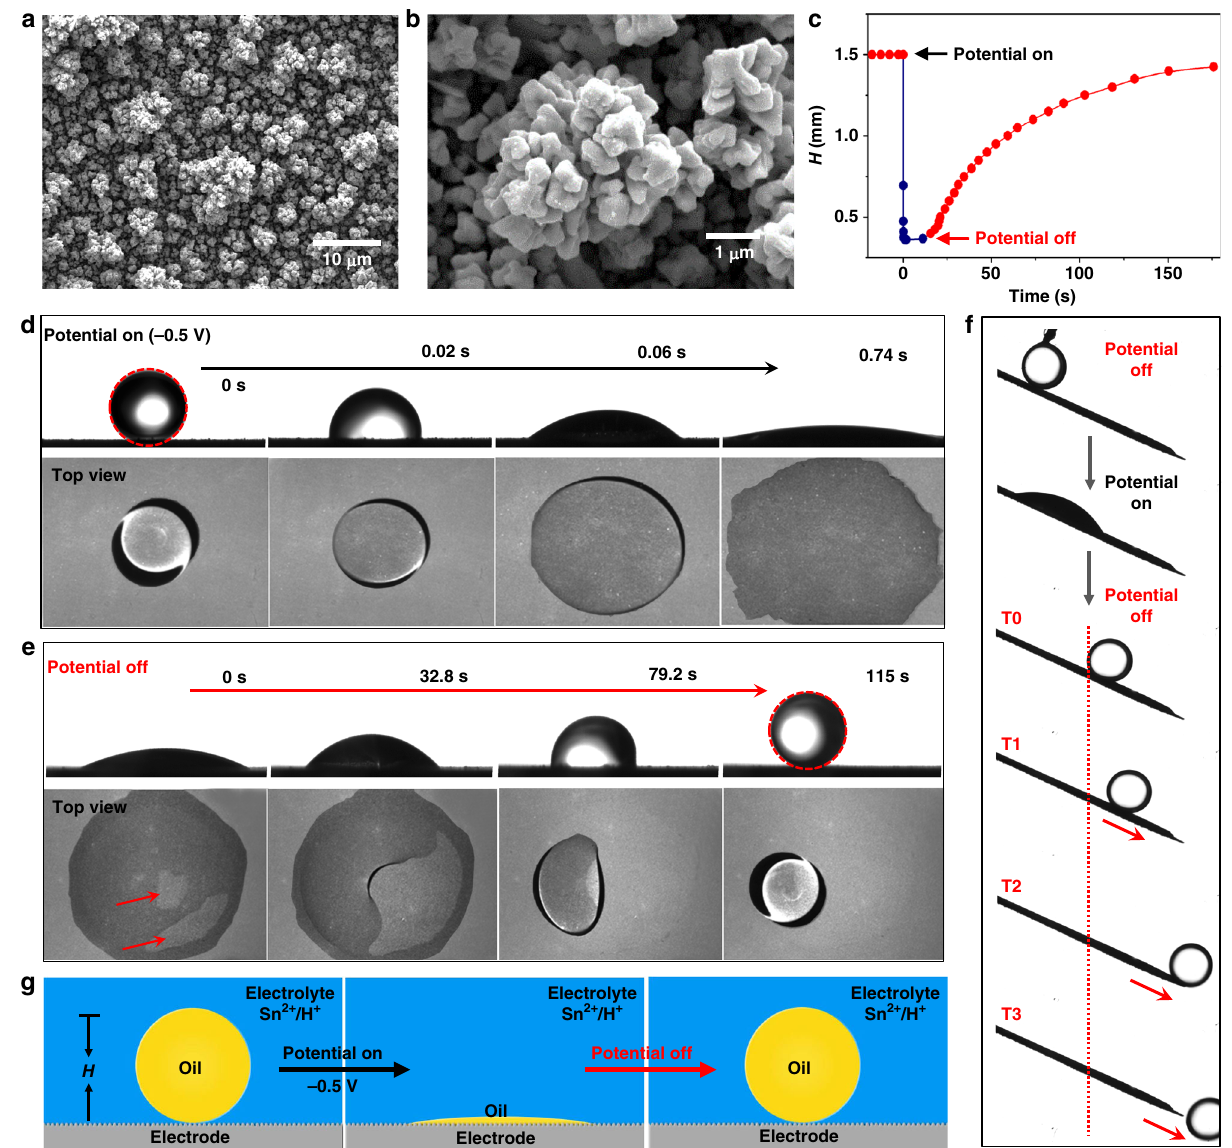
Fig. 1 In situ reversible superwetting transition between underwater superoleophilicity and superoleophobicity. a , b Scanning electron microscopic images of the copper electrode show the typical hierarchical micro-/nanostructures. c The corresponding heights of the oil droplet during the underwater superoleophobic – superoleophilic – superoleophobic transition in the presence and absence of the voltage. d , e In situ characterization of the morphology variation for a 2 μ L 1,2-dichloroethaneoil droplet on a rough copper electrode. The side and top views d for the oil spreading process when the potential is on (i.e., the transition from underwater superoleophobicity to superoleophilicity) and e for the process where the spread oil retracts into a spherical shape when the potential is off. f The oil drop can even roll away from a tilted substrate after an in situ reversible wettability conversion of superphobicity – superphilicity – superphobicity. g A drawing illustrating the whole in situ reversible superwetting